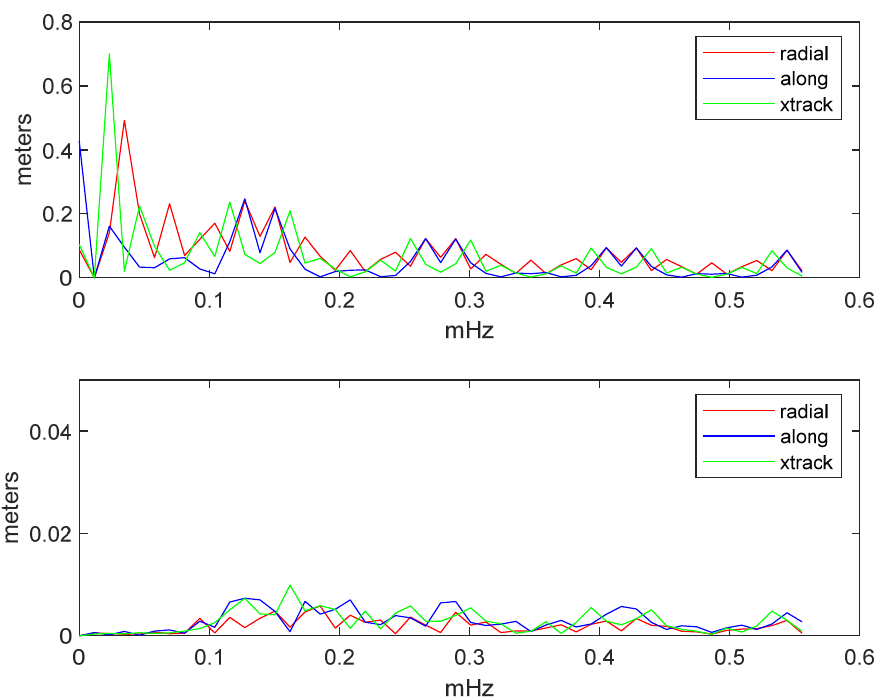
Figure 16. spectrum of the pre-fit (top) and post-fit (bottom) residuals of the coordinates of the Glonass satellites relative to the CNES precise ephemeris, projected on the radial, tangential and across track basis. Average values for January 2020.